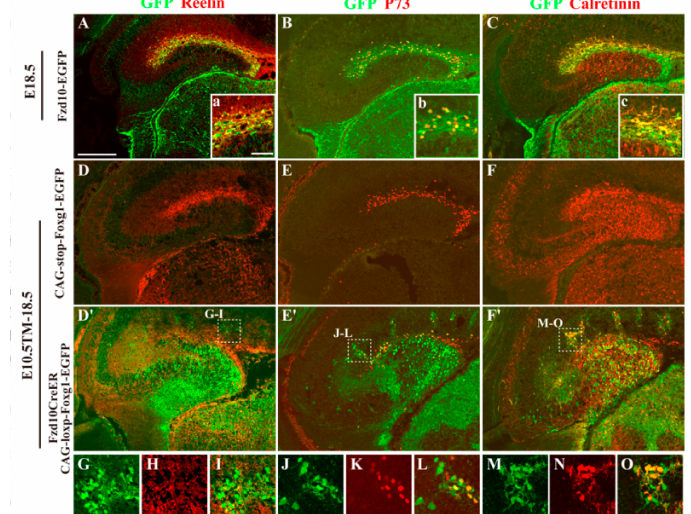
Figure 2. Most hem-derived cells lost CR cell fate and mis-distributed in the DG area. ( A – C ) Double immunofluorescence analysis of GFP and Reelin ( A ), P73 ( B ), and Calretinin ( C ) on coronal brain sections of Fzd10-EGFP brains at E18.5. The hem-derived GFP cells are both Reelin + , P73 + and CR + , hippocampal MZ. ( D – F ) Confocal images of immunofluorescence of GFP and Reelin ( D ), P73 ( E